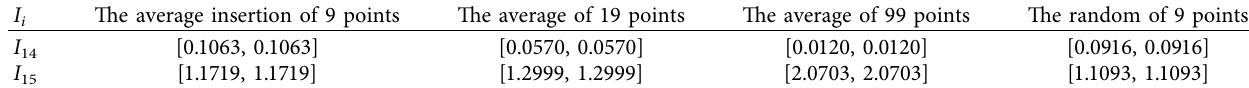
Table 5: Interval information content of I